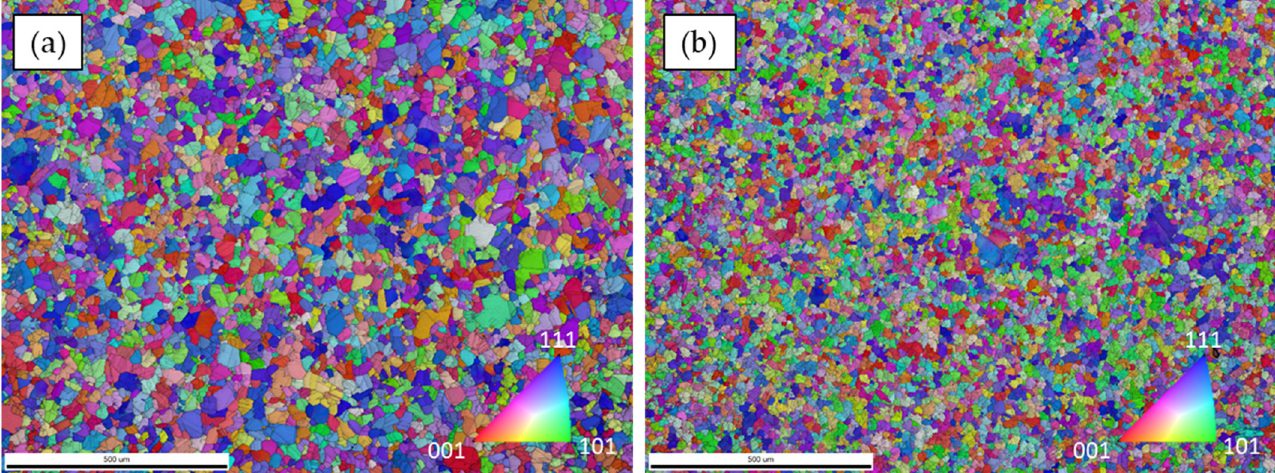
Figure 1. Electron backscatter diffraction (EBSD) grain maps with inverse pole figure (IPF) coloring and removed twins: ( a ) Material A: coarse microstructure; ( b ) Material B: fine microstructure. Table 1. Microstructural constituents and mechanical properties from all tested materials.